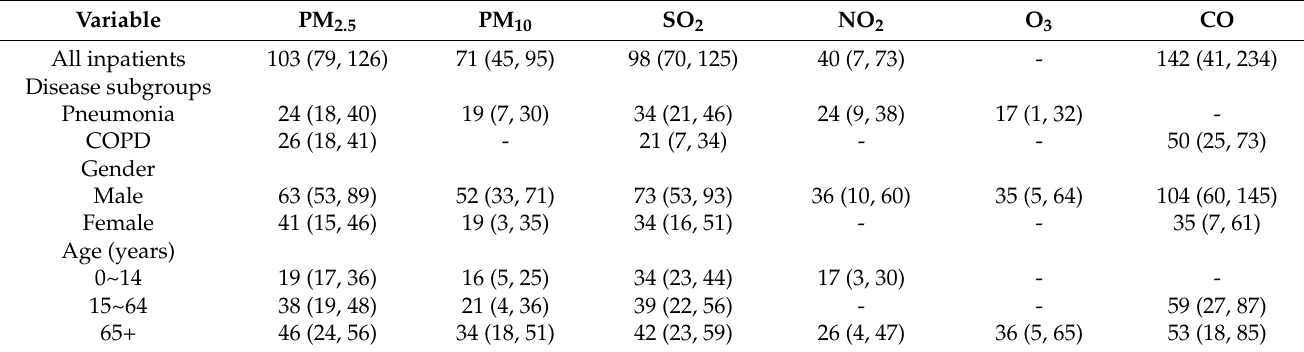
Table 11. Economic losses of inpatients for respiratory disease due to air pollutants (95% CI) (unit: million USD).